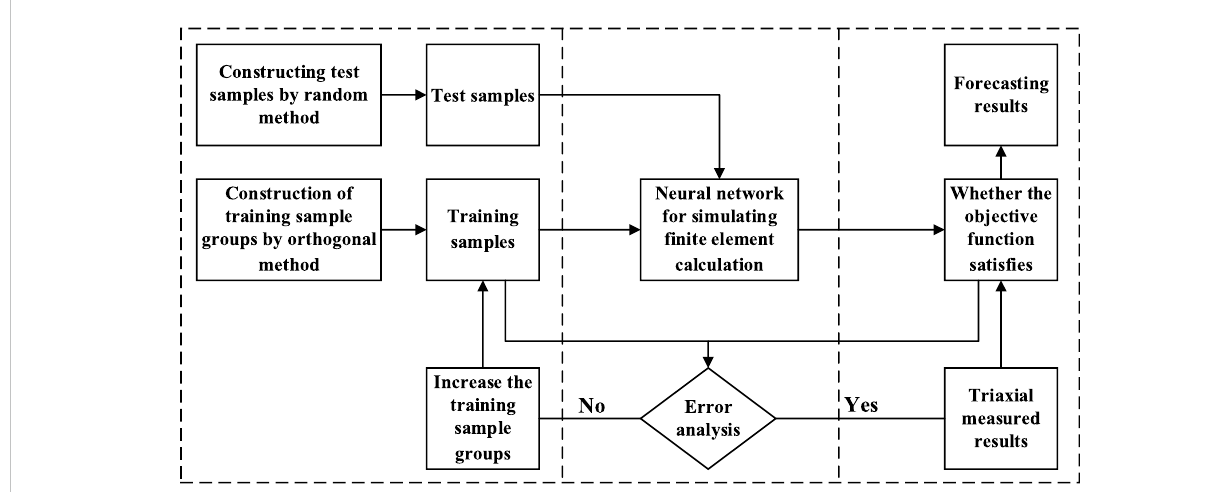
FIGURE 10 Analysis method of wetting deformation prediction model of BP neural network.